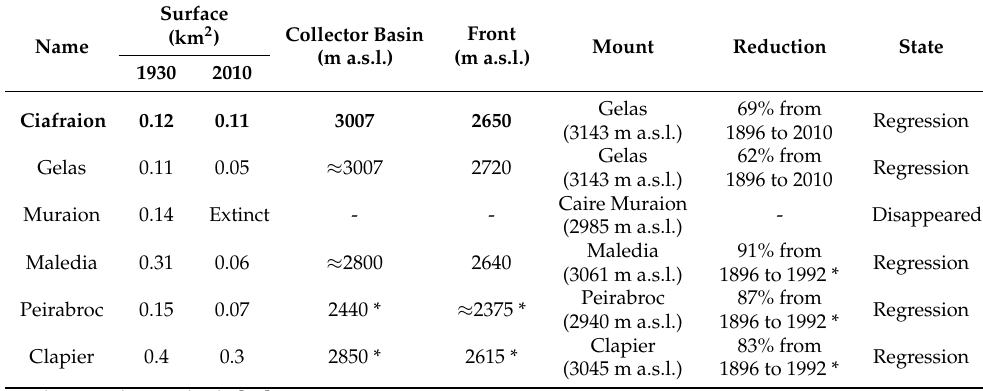
Table 1. Information regarding glaciers and their surface characteristics. The glaciers are listed from west to east. The information shown is adapted from Mercalli and Cat Berro [27] and from the Nimbus website (http://www.nimbus.it/), except those with an asterisk.